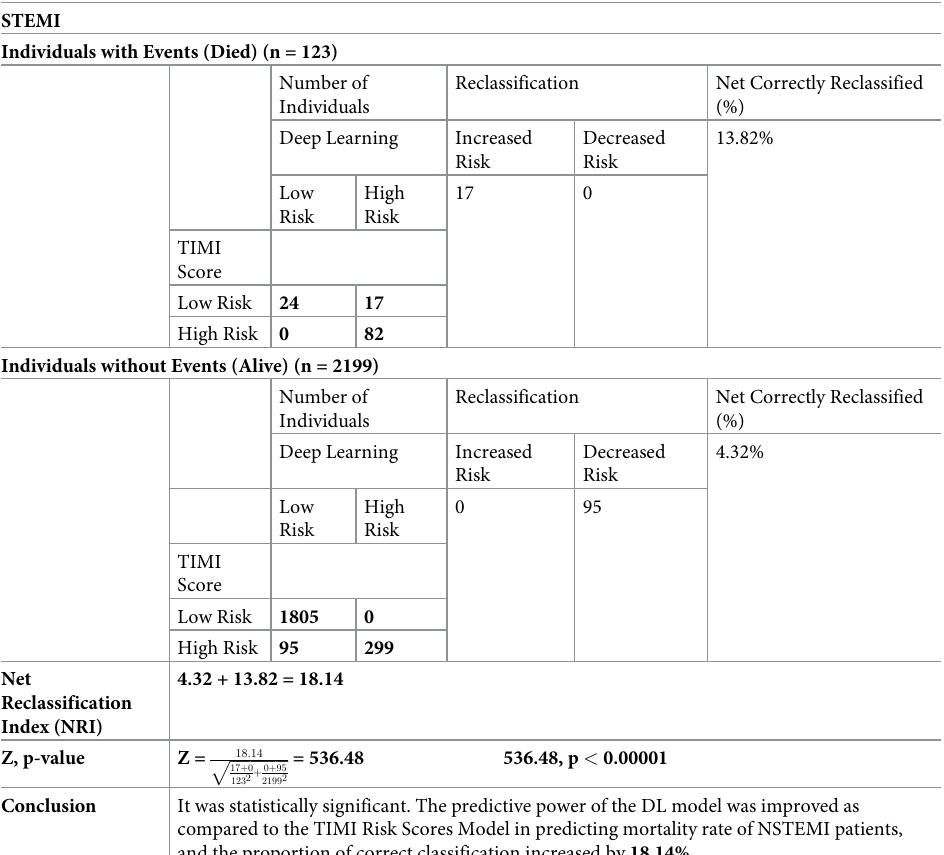
Table 8. NRI for STEMI